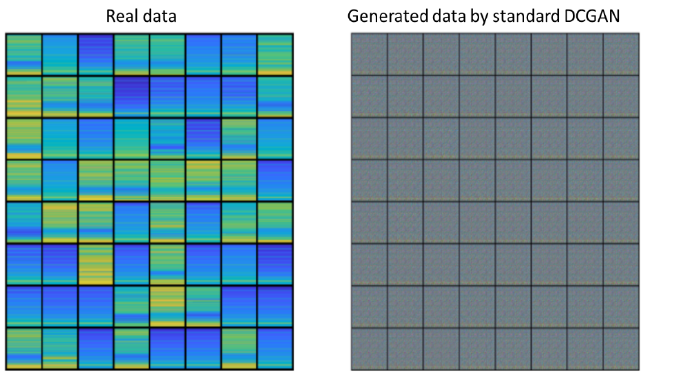
Figure 9. Generated data through standard